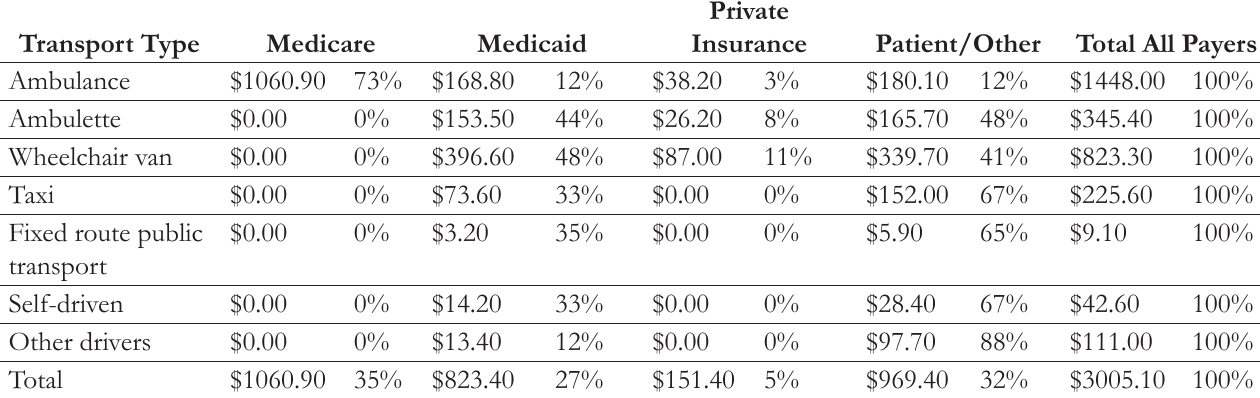
Table 7. 2012 Costs ($ Millions) and Percent of Costs by Transport Type, by Payer Transport